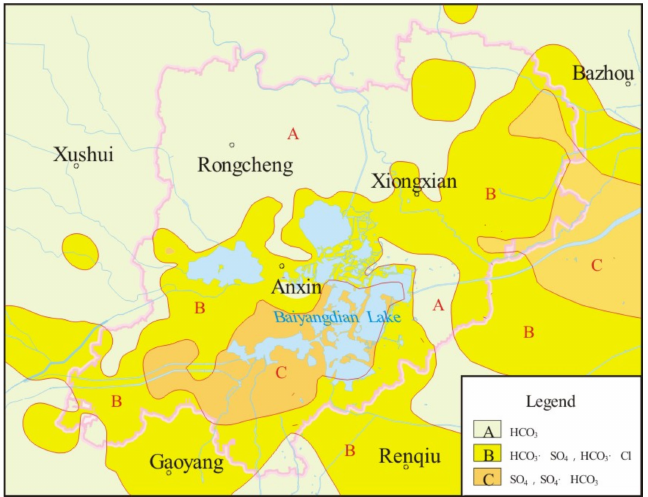
Figure 4. Hydrochemical types of shallow groundwater in Xiong’an New